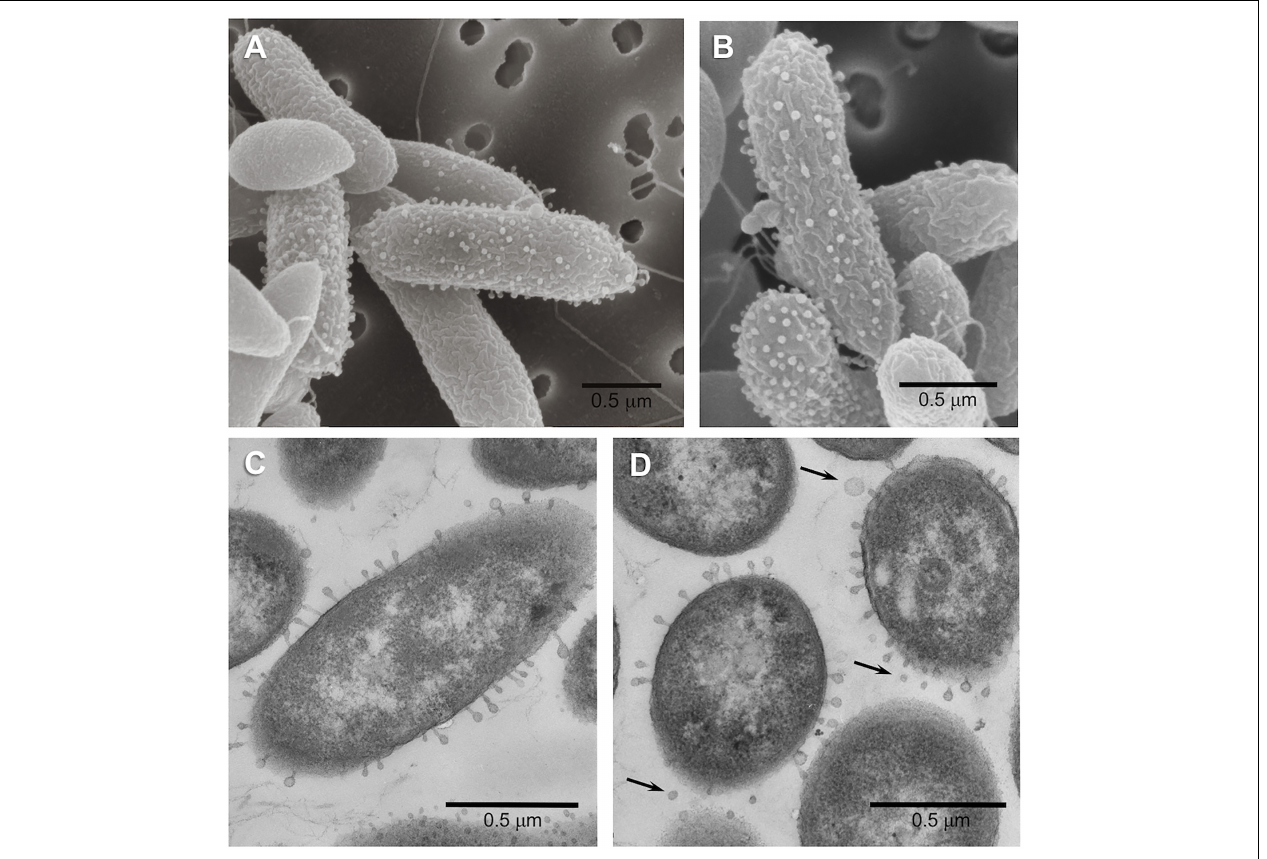
FIGURE 4 | Scanning (A,B) and transmission (C,D) electron micrographs of cells of Pseudomonas strain LFY10 grown at 4 ◦ C. Surface blebbing can be seen in both SEM and TEM imaging and are visible only on some cells. These structures, some of which appear to be completely detached (arrows, D) , are likely membrane vesicles produced by this Gram-negative bacterium. Note also the presence of polar flagella in the SEM images.